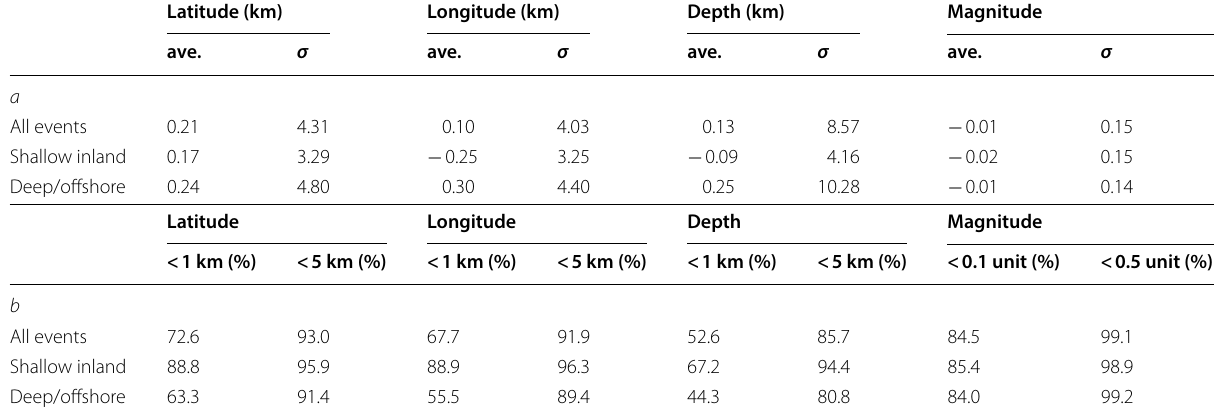
Table 2 Residuals between fully reviewed events (flag “K”) in the JMA catalog and their corresponding automatically processed hypocenters by the PF method: a averages (ave.) and standard deviations ( σ ), b proportions of automatically processed hypocenters within 1 and 5 km and 0.1 and 0.5 units of the fully reviewed hypocentral location and magnitude in the JMA unified catalog,